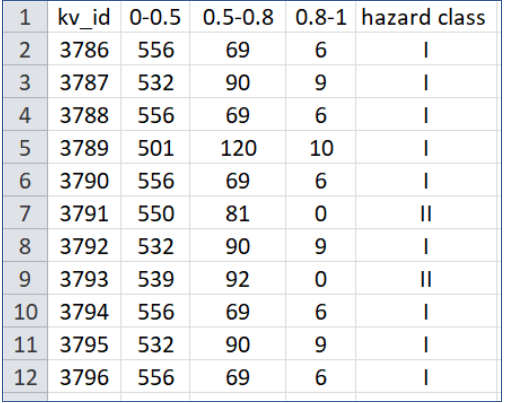
Figure 11. A fragment of the CSV file with the results of summing the cases by intervals of similar- ity.